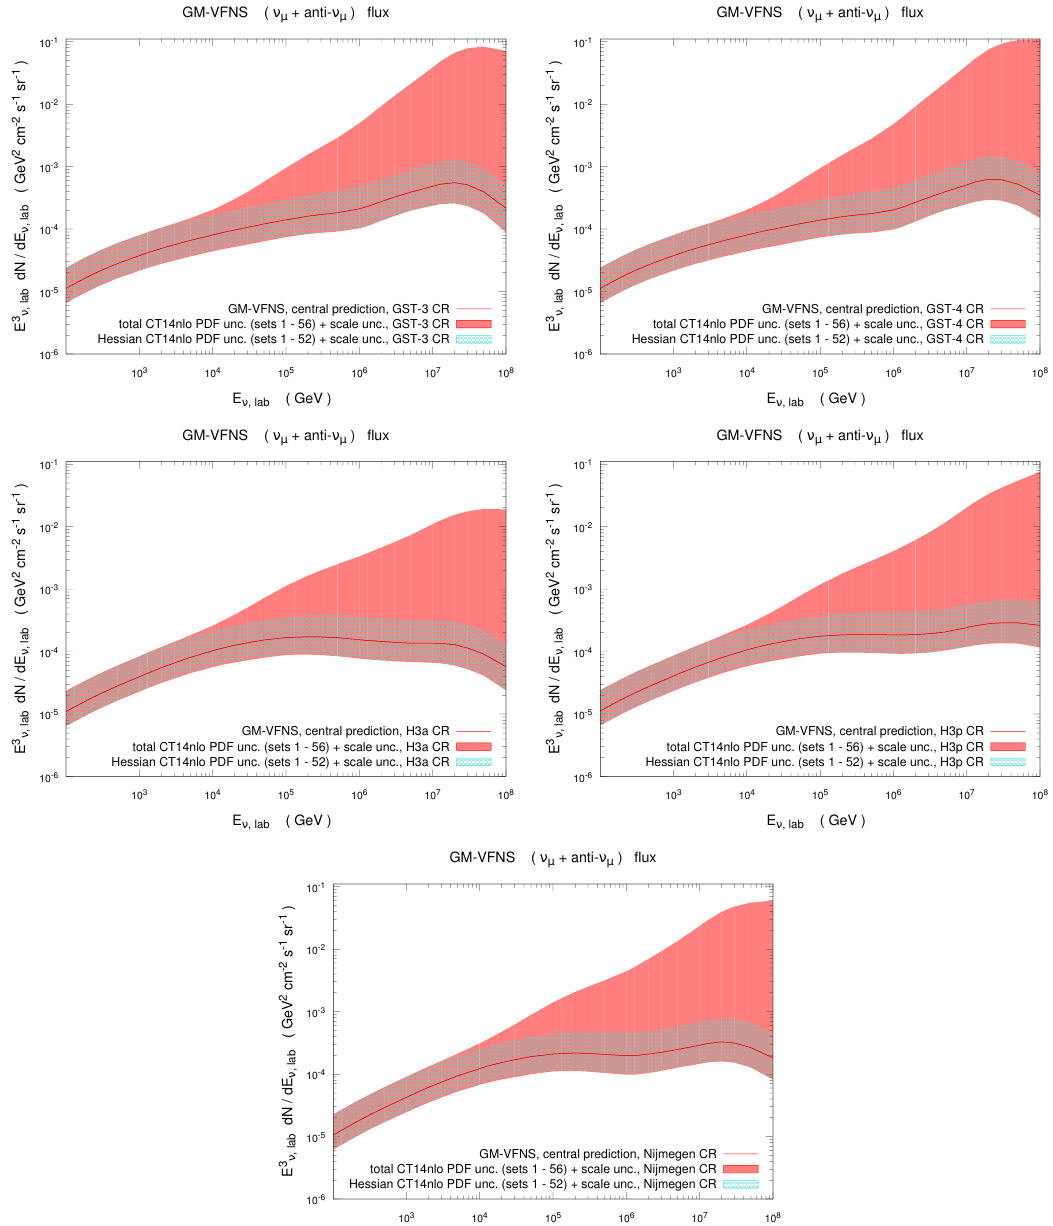
Figure 11 . Total uncertainties in prompt-( (cid:23) (cid:22) + (cid:22) (cid:23) (cid:22) ) (cid:13)uxes due to scale and PDF variations, computed by considering all 56 PDF sets of the CT14nlo (cid:12)t (pink solid bands), as compared to those arising when restricting the PDF variation to the Hessian sets (light-blue hatched bands). Each panel refers to a di(cid:11)erent CR primary spectrum (GST-3, GST-4, H3a, H3p and Nijmegen).